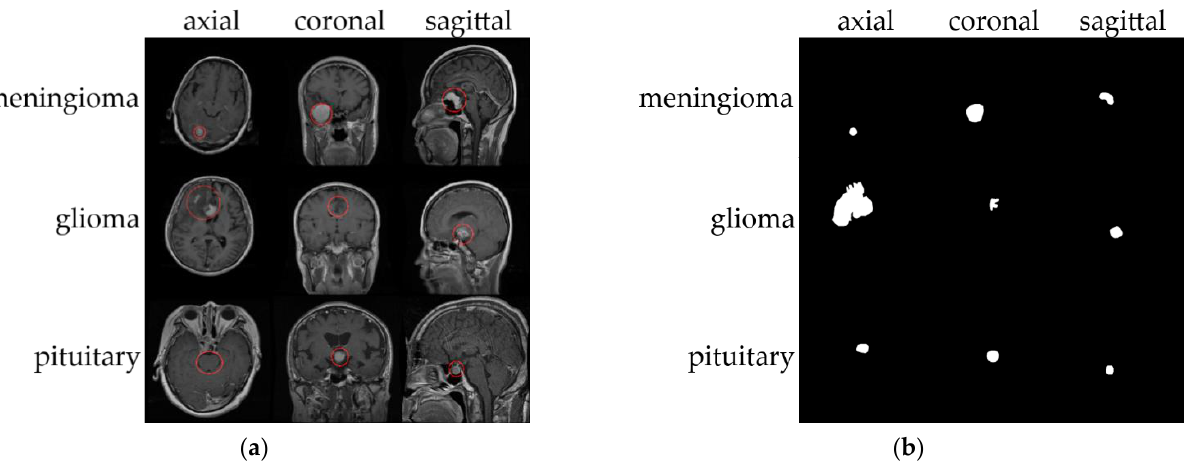
Figure 1. Image example for each type of tumor in each of the planes from the database [25]: ( a ) Normalized MRI images with bordered tumors; ( b ) Corresponding tumor masks.